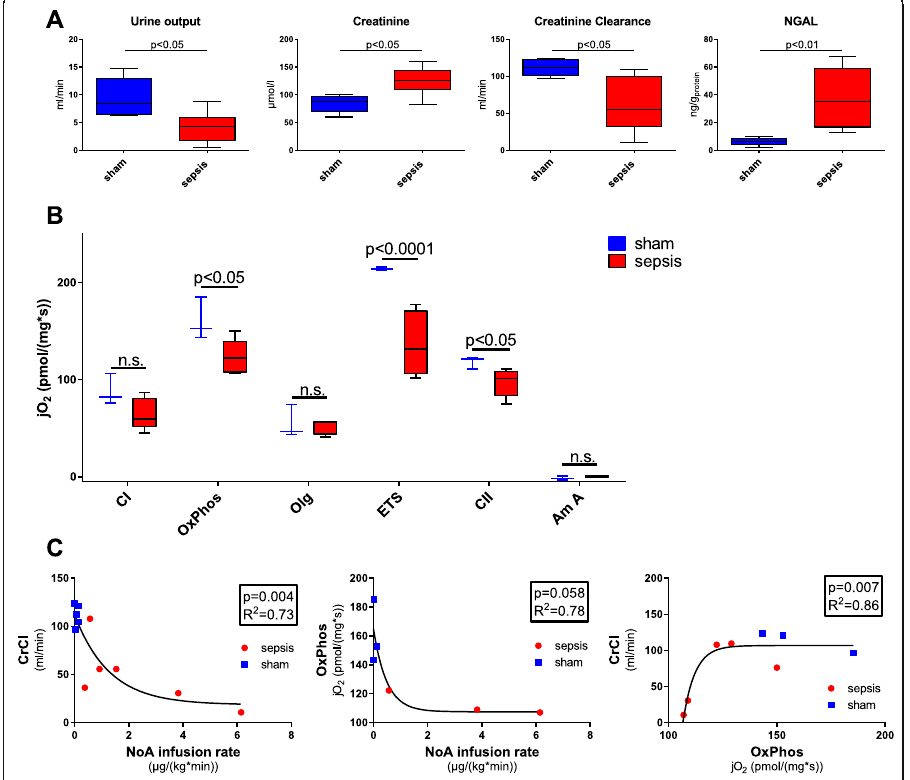
Fig. 2 Parameters of kidney function. a Physiological parameters: urine output, plasma creatinine (Creatinine), creatinine clearance (CrCl), and renal venous neutrophil gelatinase-associated lipocalin (NGAL) (all values sham n = 5, sepsis n = 8). b Kidney mitochondrial respiratory activity (sham n = 3, sepsis n = 5). jO 2 , oxygen consumption; CI, mitochondrial respiratory activity in the coupled state stimulated with complex I substrates and ADP; OxPhos, maximum mitochondrial respiratory activity in the coupled state with complex I and II substrates, fatty acids, and ADP; Olg, leak respiration after inhibition of ATP-synthase with oligomycin; ETS, maximum mitochondrial respiratory activity after uncoupling with FCCP; CII, uncoupled mitochondrial respiratory activity linked to complex II after inhibition of complex I by rotenone. c Plotting of CrCl and mitochondrial activity to noradrenaline infusion (NoA). * p < 0.05; ** p < 0.01; n.s. p >